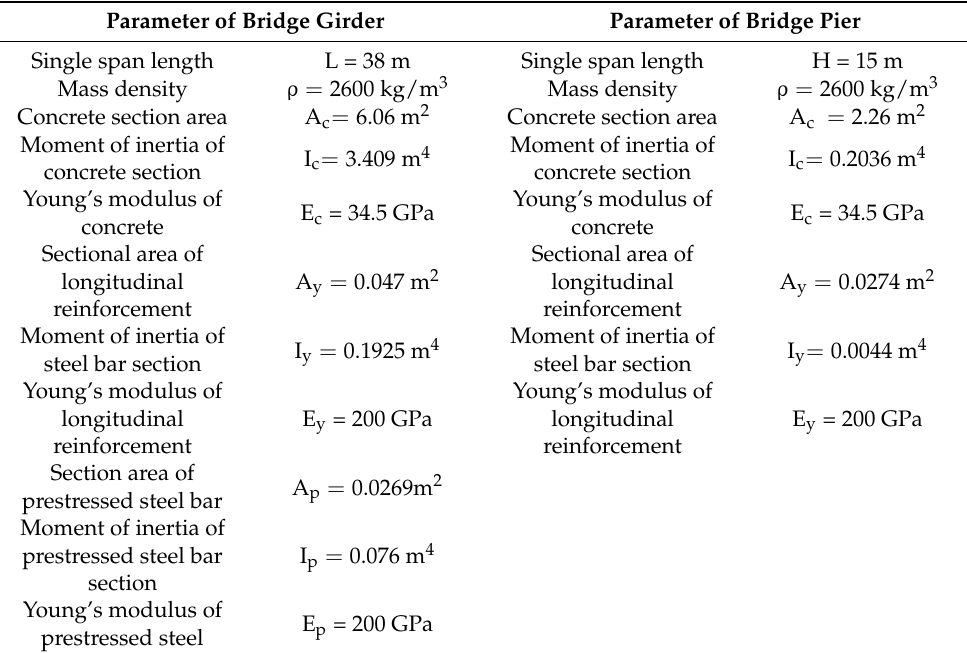
Table 1. The parameters of the bridge girder and